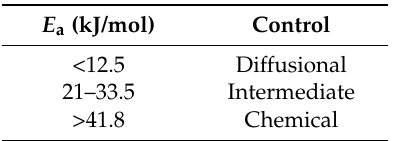
Table 4. Control according to the E a value.